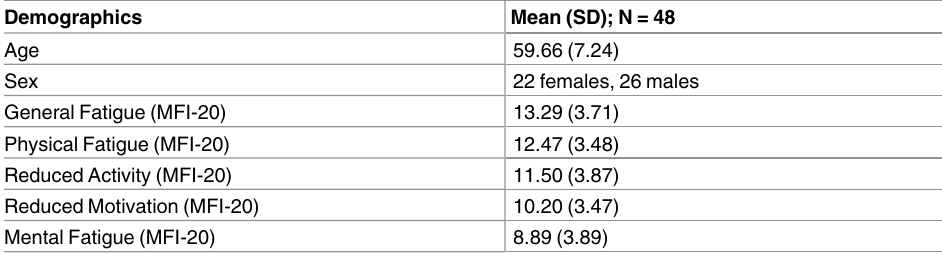
Table 1. Demographics, mean and SD of MFI-20